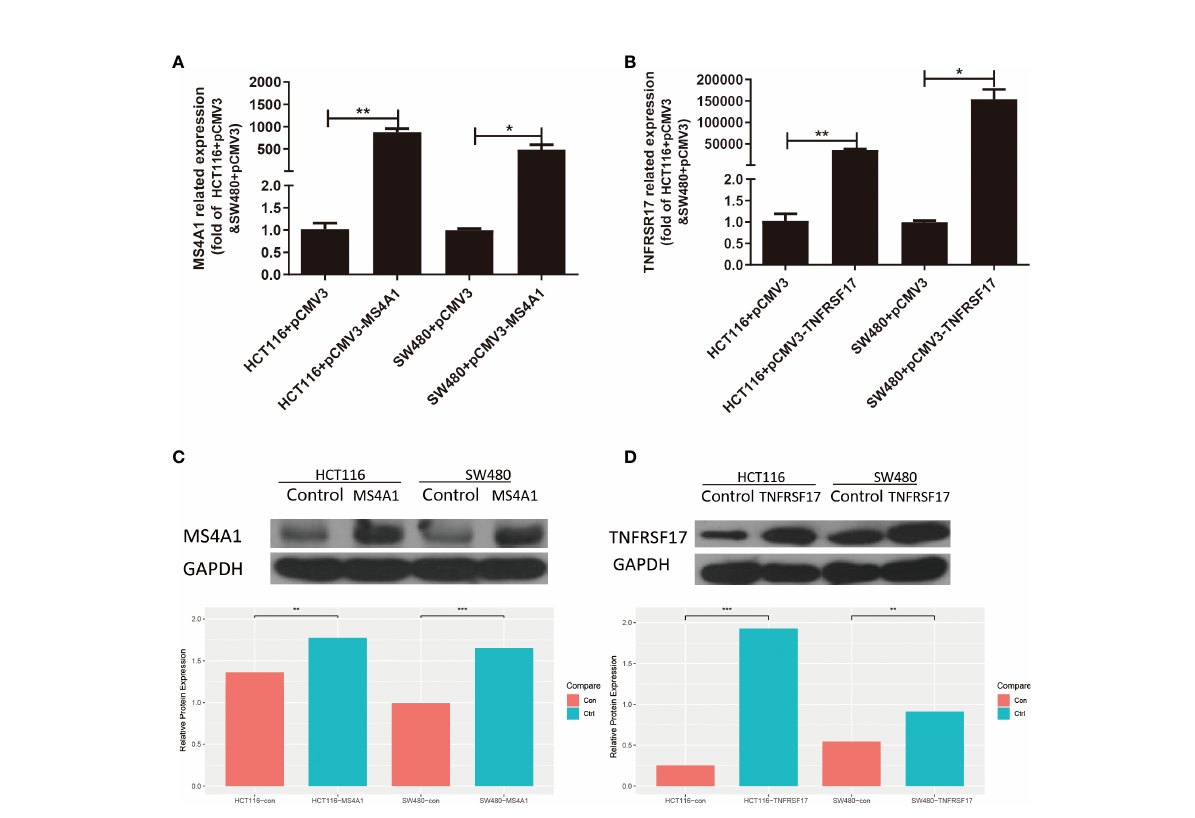
FIGURE 7 Expression changes after transfection of MS4A1 and TNFRSF17. (A, B) Compared with the empty negative control group, both MS4A1 and TNFRSF17 gene overexpression plasmids transfected into SW480 and HCT116 cells, the RNA levels detected by QPCR were overexpressed (C, D) Compared with the empty negative control group, both MS4A1 and TNFRSF17 gene overexpression plasmids were transfected into SW480 and HCT116 cells, and the protein levels detected by WB had overexpression effects. *,<0.05; **,<0.01;